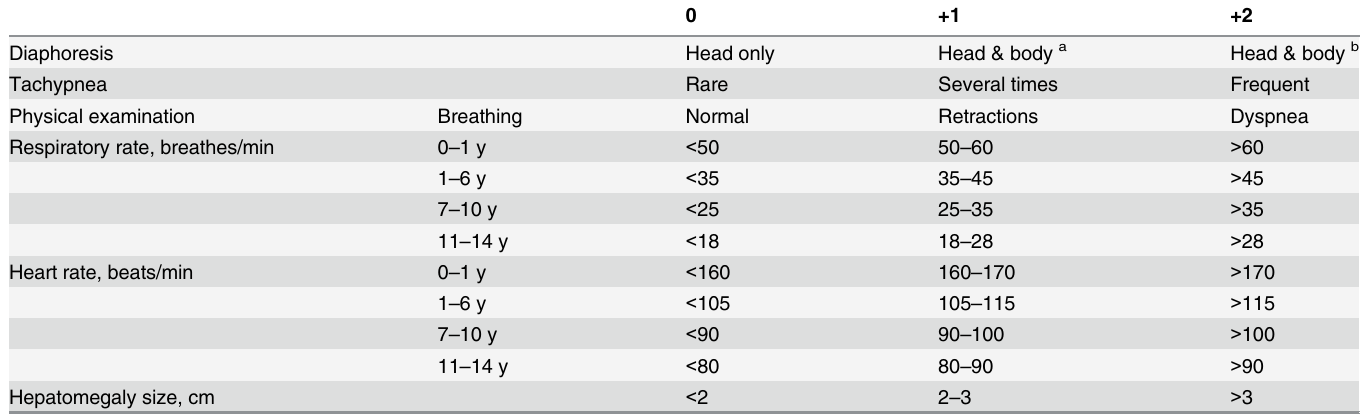
Table 1. Modified Ross Score.